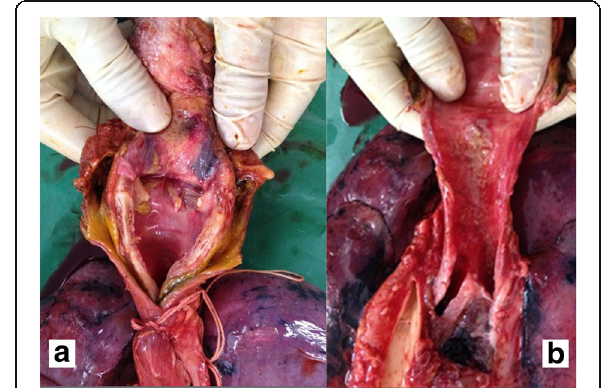
Fig. 2 a Haemorrhage and yellowish discolouration of mucosa in the glottic region. b Mucosal corrosion with yellowish plaques in the larynx, trachea and bronchus